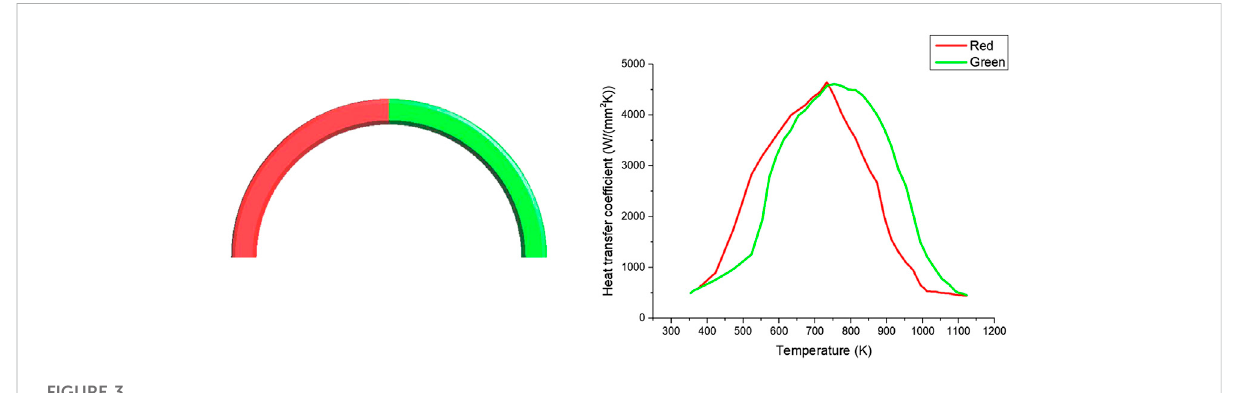
FIGURE 3 Surface heat transfer coef fi cient law of GCr15 steel quenched in oil.